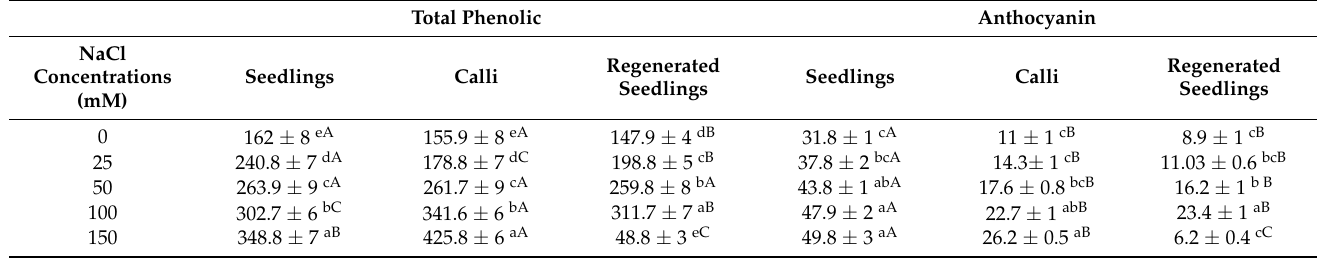
Figure 6. Effect of salinity on secondary metabolites of Carum copticum. Mature sterilized seeds and regenerated seedlings were grown on MS medium containing 0, 25, 50, 100, and 150 mM NaCl. Calli were cultured on MS medium containing 1 mg L − 1 BAP, 0.25 mg L − 1 2,4-D, and the above-mentioned concentrations of NaCl. Total phenolic ( A ) and anthocyanin ( B ) contents of shoots were measured after 4 weeks of salt treatment. Values represent the mean of three replicates with error bars indicating ± standard errors. Different lowercase letters indicate significant differences among the 5 NaCl concentrations in an explant of Carum copticum, and different uppercase letters indicate significant differences among 3 explants of Carum copticum within the same NaCl level according to Duncan’s test p ≤ 0.05. Table 8. Comparison of total phenolic and anthocyanin contents in three explants of Carum copticum under five NaCl concentrations.